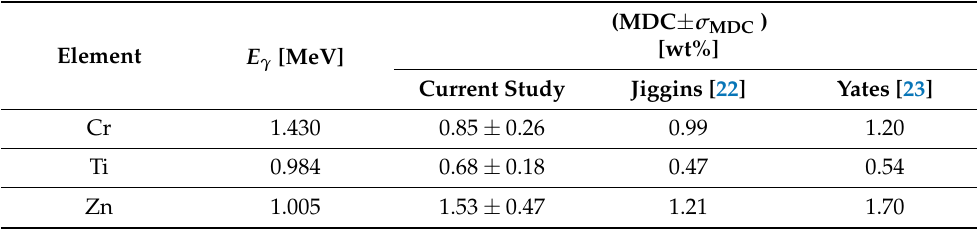
Figure 8. The yields of zinc prompt gamma ray at 1.01 MeV as a function of its concentration in soil samples. The solid line represents the best fit for the data using the inverse variance weighting scheme. Table 2. The measured MDC values for Cr, Ti, and Zn in soil samples using 2.5 MeV neutron inelastic scattering prompt gamma